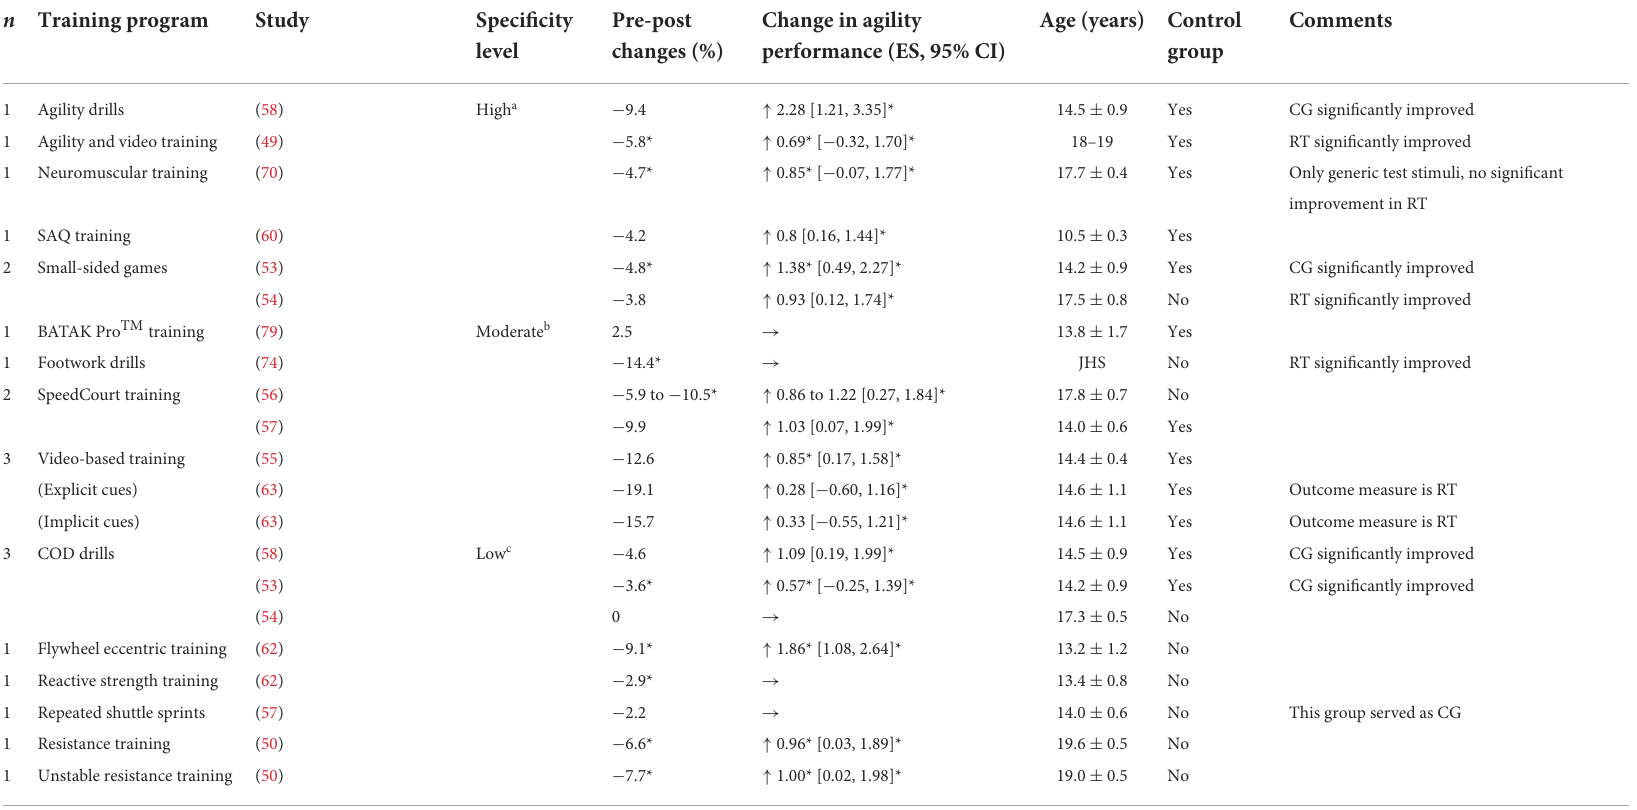
TABLE 3 Overview of training programs and respective